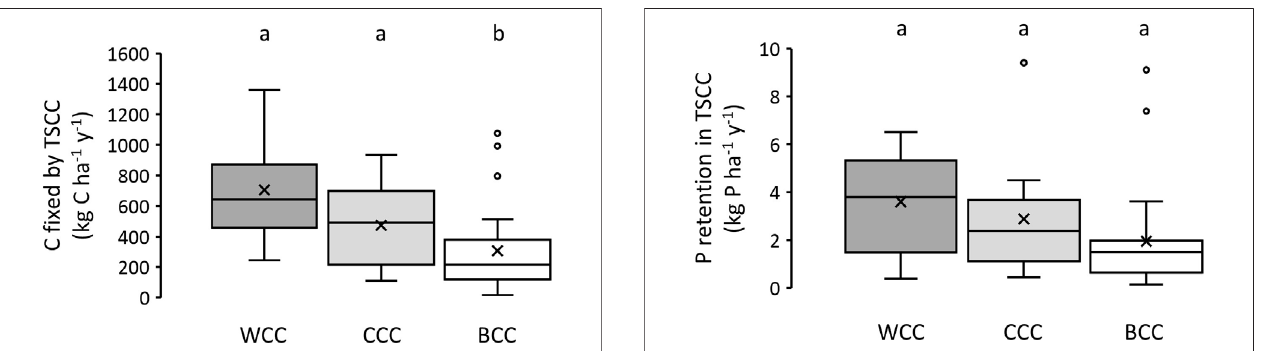
FIGURE 6 | Box and whiskers plot of carbon content of TSCC for each of the cover crop layout. Horizontal black line, x-shaped cross, box borders and whiskers stand for the median, the mean, quartiles and outliers. Different letters over the box-plot indicate signi fi cant differences ( p < 0.05). WCC, CCC and BCC stand for olives groves where TSCC occupied the whole area, was absent under tree canopy or only occupied a strip of the inter-row area, respectively.